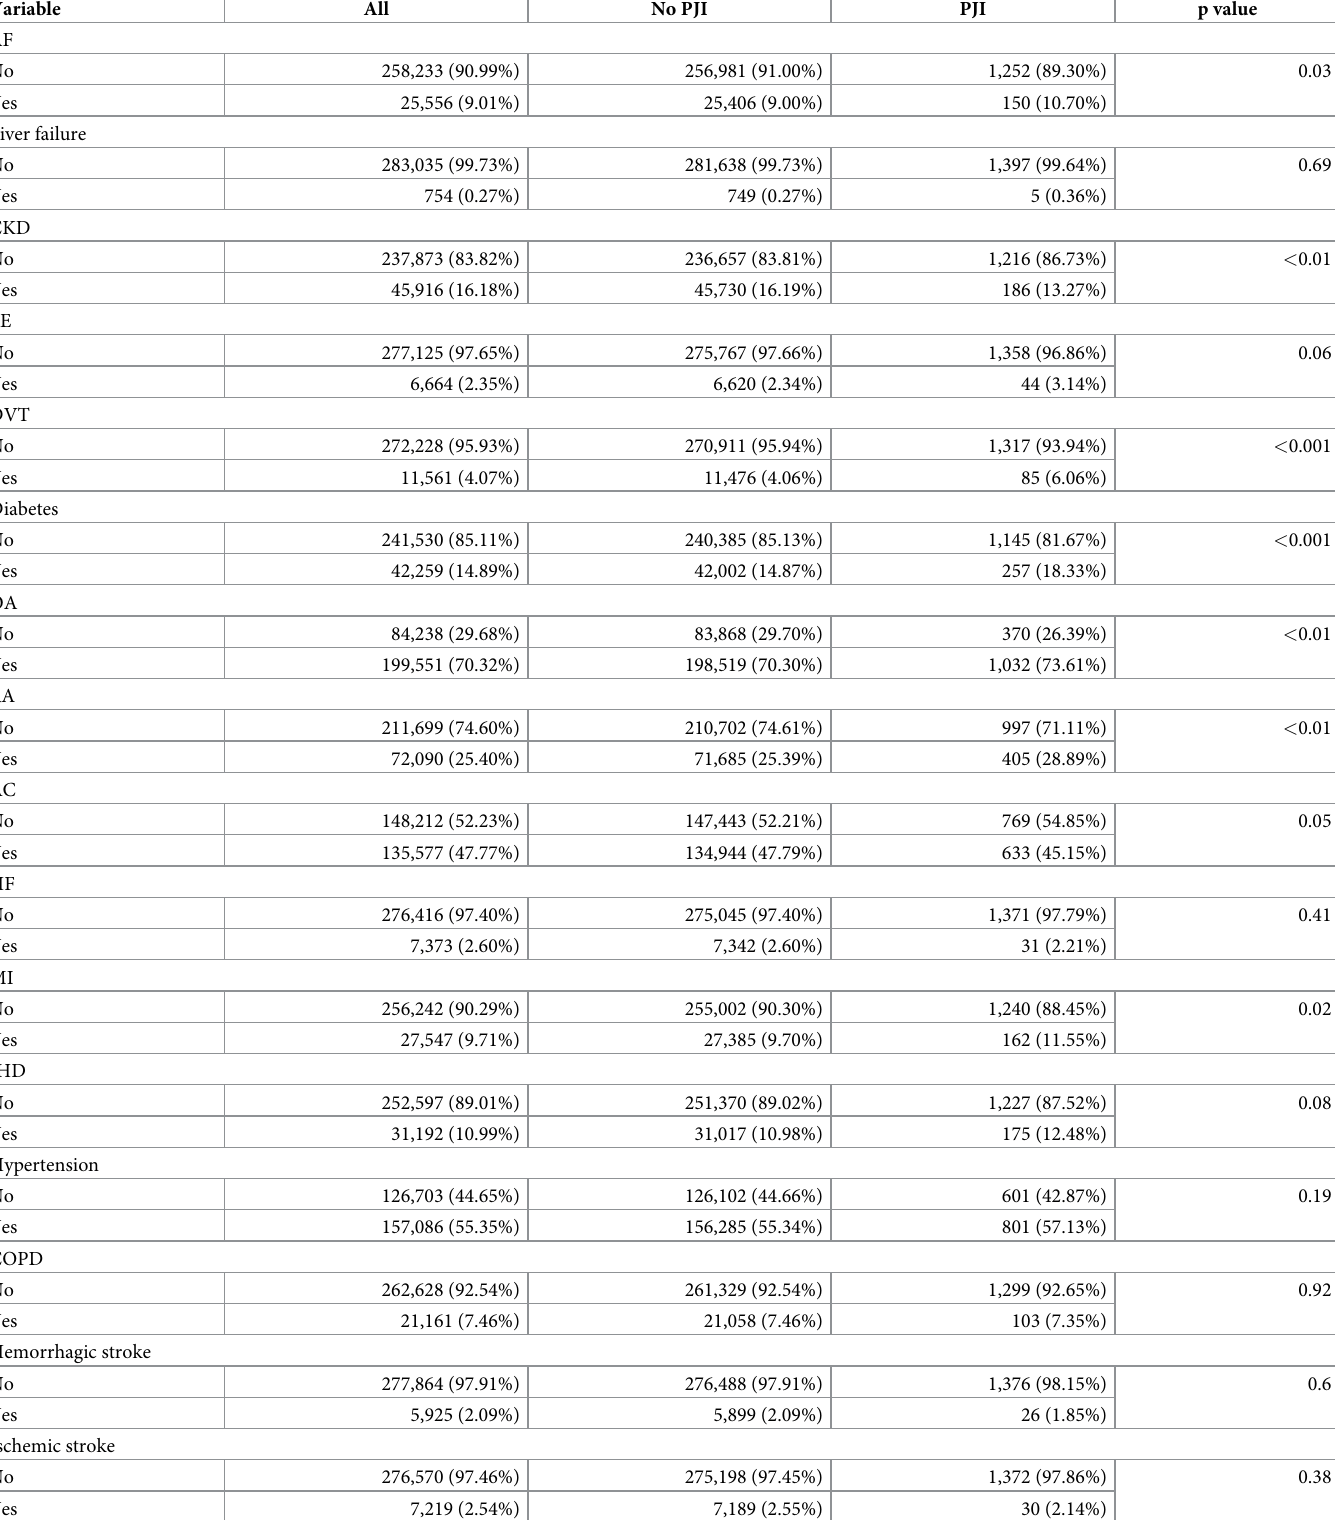
Table 3. Medical history of patients at the time of hip or knee implant